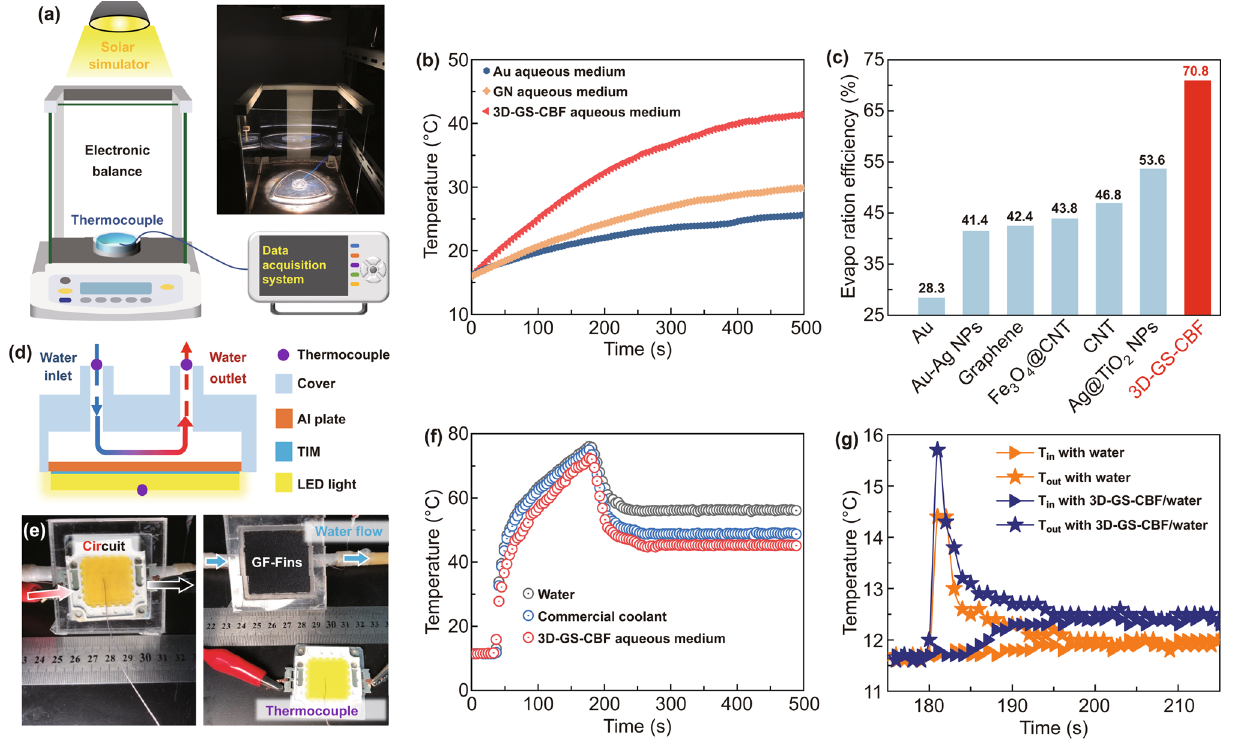
Fig. 4 a Schematic of experimental setup for solar thermal conversion application. The apparatus includes a solar simulator, an electronic bal- ance, thermocouples and data acquisition system. The inset denotes the photograph of apparatus. b Temperature of Au, GN and 3D-GS-CBF aqueous mediums as a function of illumination time at 1 sun. c Comparison of solar vapor generation efficiency between our work and previ- ous studies. d Schematic of experimental setup for LED thermal management application. Water flows through the block from inlet to outlet. e Photographs of devices, showing the electric current and water flow. f Surface temperature of LEDs as a function of time for water, commercial coolant and 3D-GS-CBF aqueous mediums. g Water temperature at the inlet and outlet of LEDs as a function of